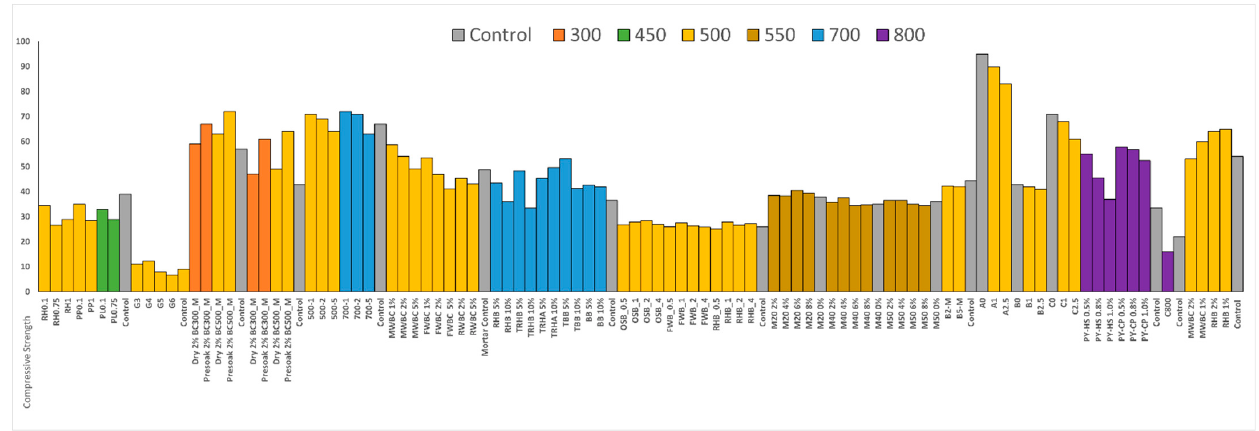
Figure 4. Compressive strength of biochar cement and concrete composites reported in previous studies.